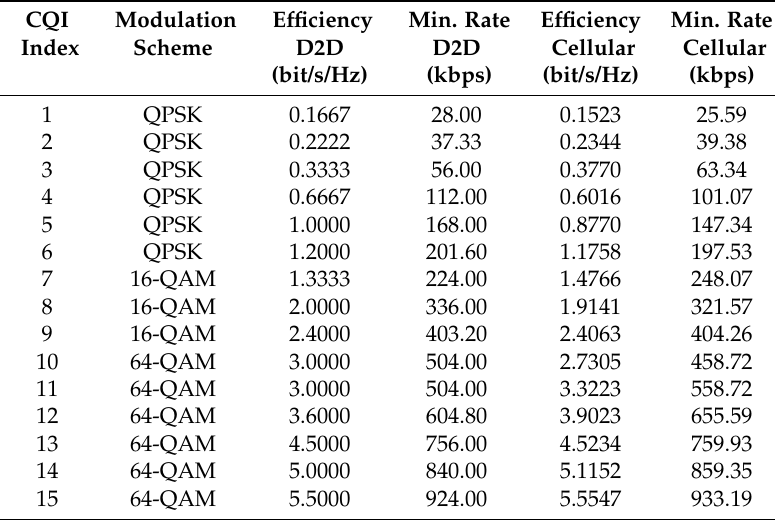
Table 1. CQI-MCS mapping for D2D and cell-mode communication